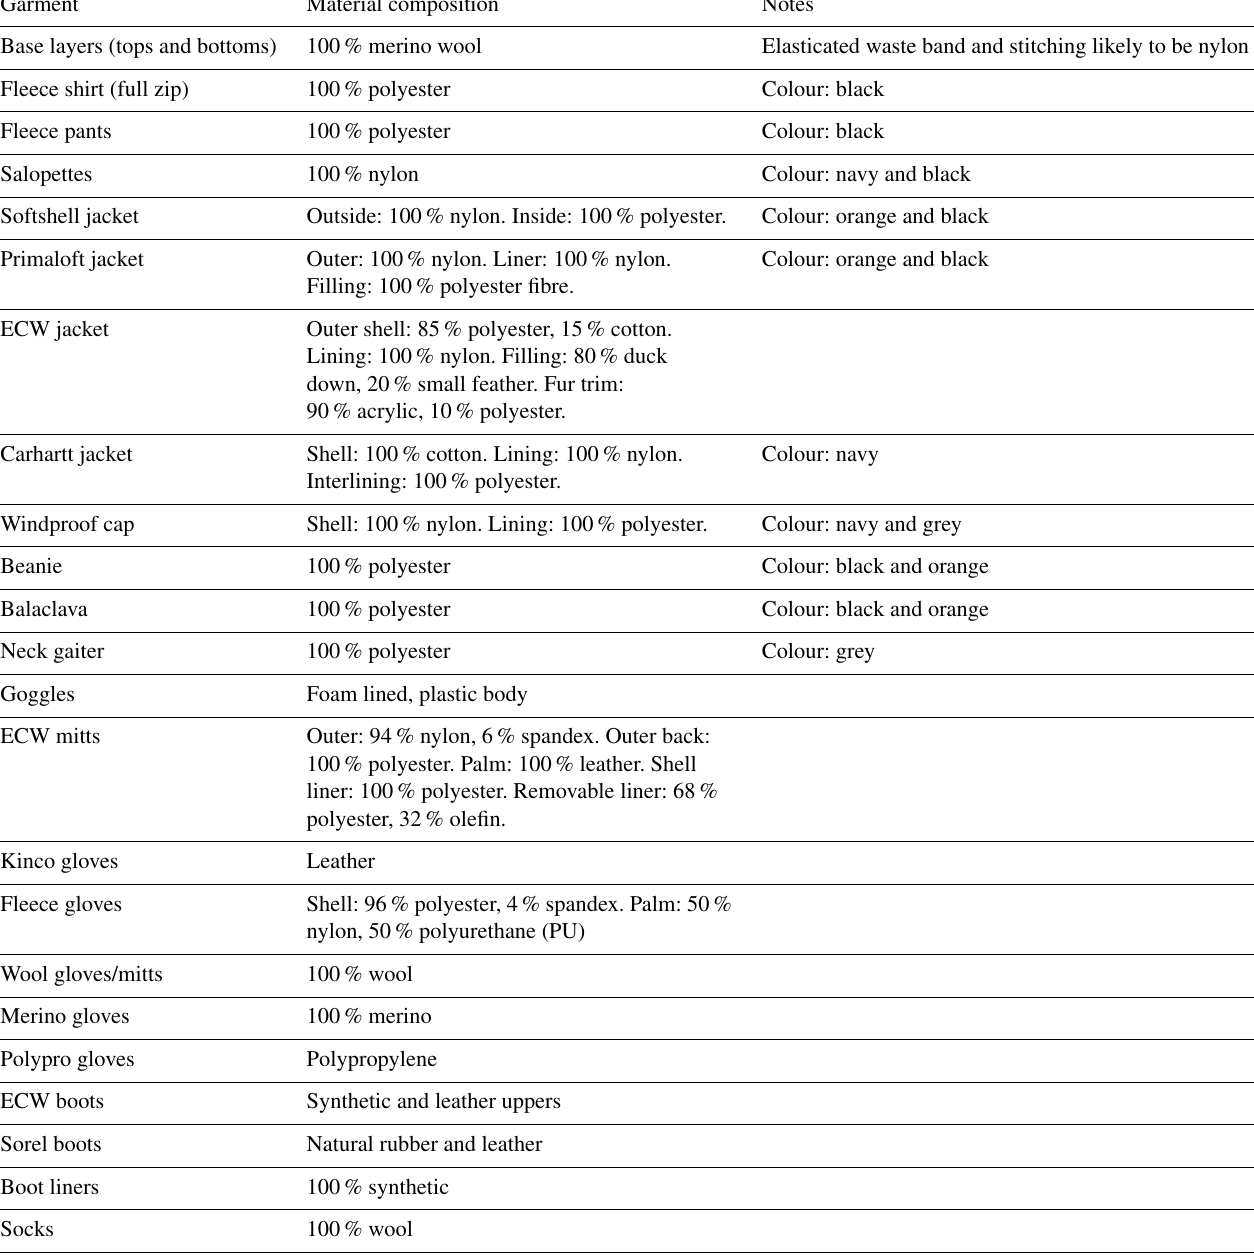
Table A1. Catalogued material used in New Zealand Antarctic programme